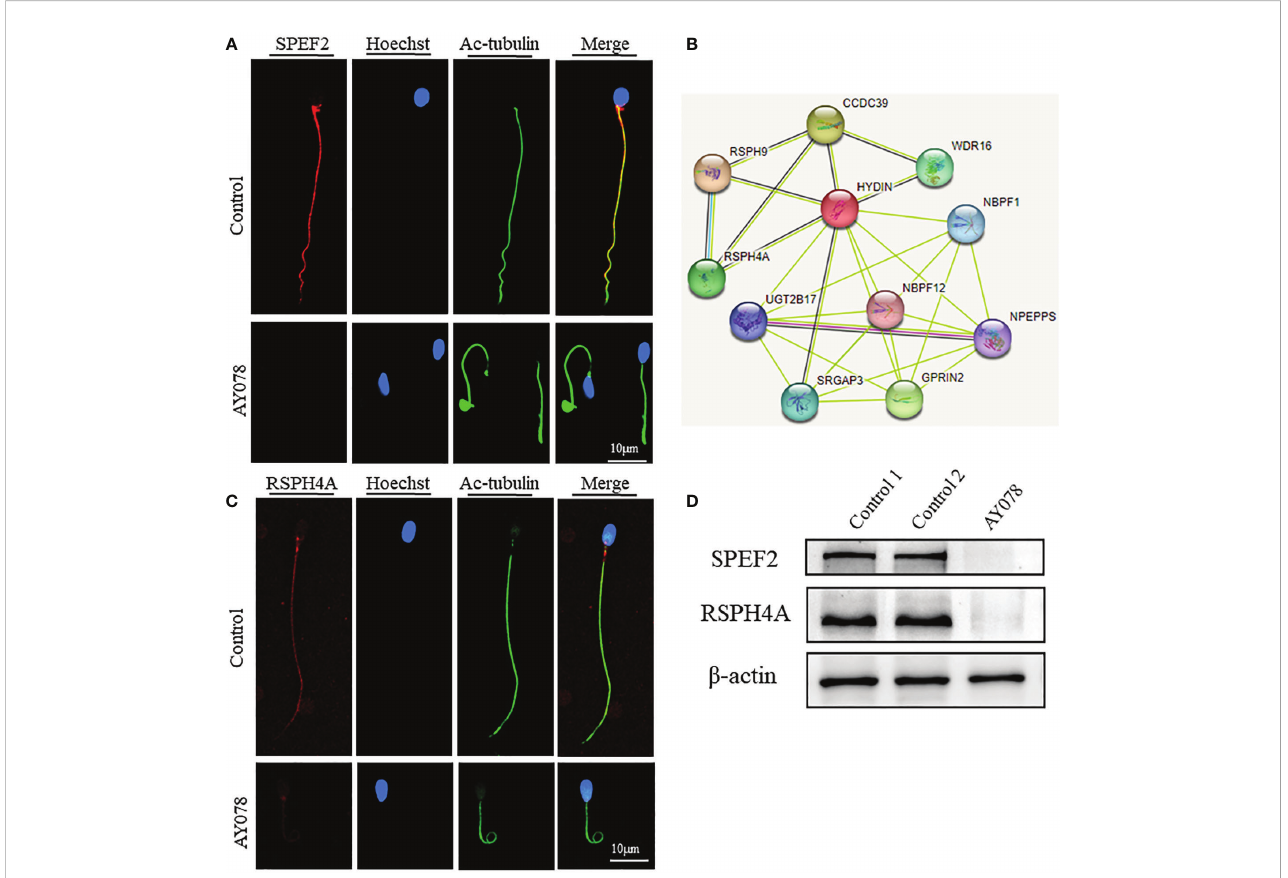
FIGURE 7 De fi ciency of axoneme and appendages in sperm from AY078. (A, C) The immuno fl uorescence assays of fl agella associated proteins SPEF2 (Sperm Flagellar2) and RSPH4A. Anti- SPEF2 ( red in B) and Anti- RSPH4A ( red in C) normally localized along the sperm fl agella in the control sperm. However, expressions of SPEF2 and RSPH4A were almost absent in sperm obtained from AY078 harboring HYDIN variants. Anti-ac-tubulin (green) marked the sperm fl agella. Hoechst (blue) labeled the nucleus of spermatozoa. Scale bars: 10 m m (B) STRING analysis towards HYDIN . Evidently, it was indicated that HYDIN may be highly connected with RSPH4A . (D) The expression levels of SPEF2 and RSPH4A in spermatozoa were analyzed by western blot from normal individual and HYDIN -de fi cient subjects. The results showed obviously decrease of those proteins. b -actin was used as internal